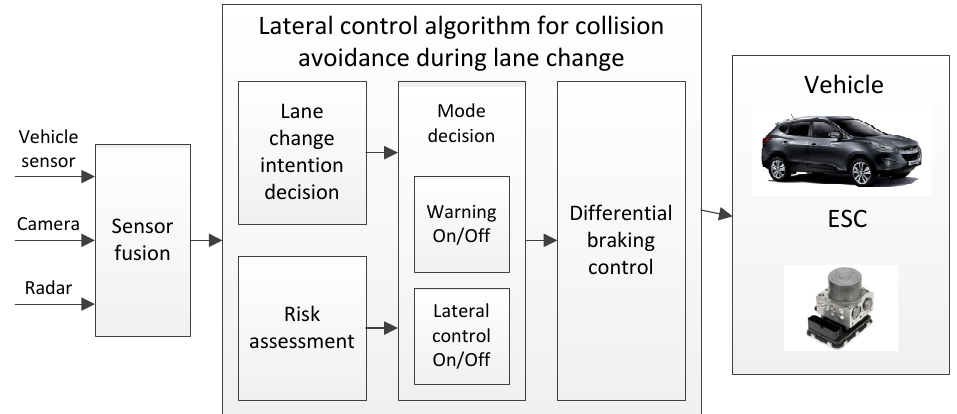
Figure 3. Architecture of the collision avoidance system.